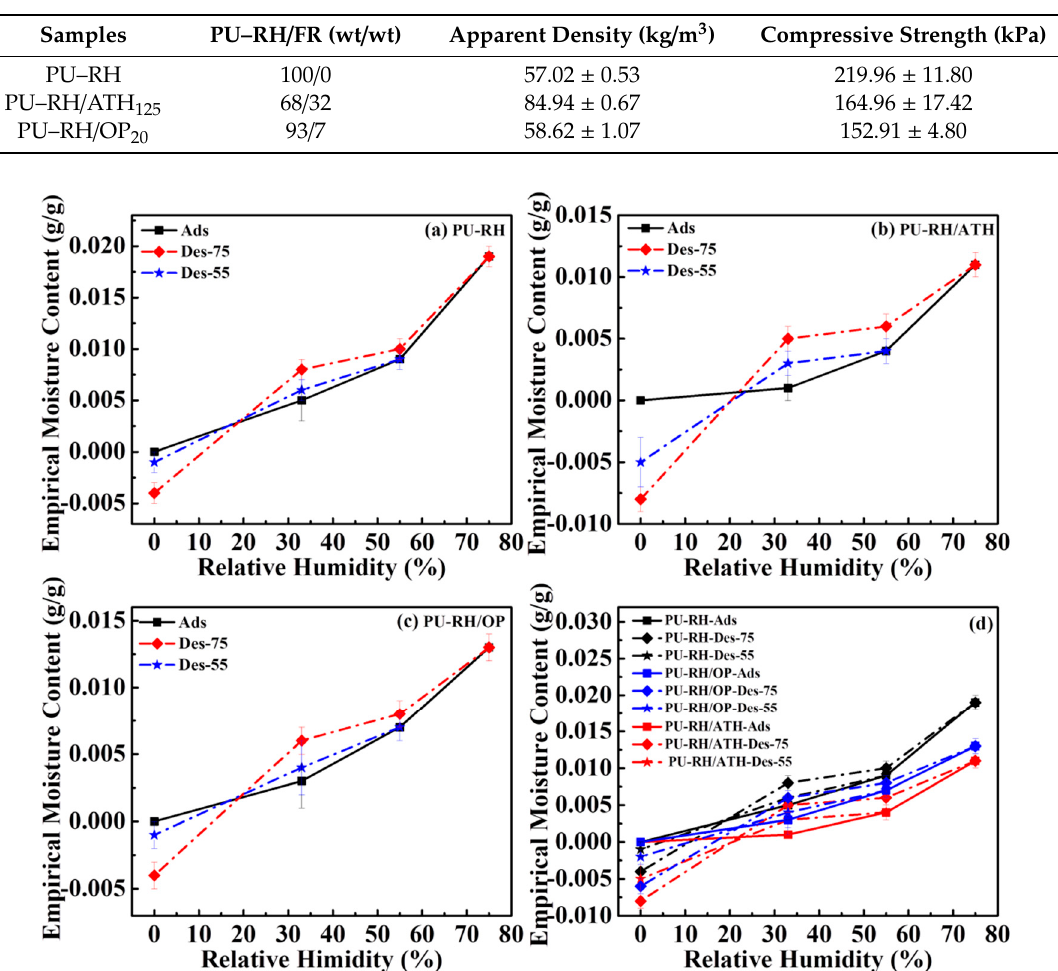
Figure 10. Sorption isotherms of ( a ) PU–RH, ( b ) PU–RH / ATH, ( c ) PU–RH / OP, and ( d ) all